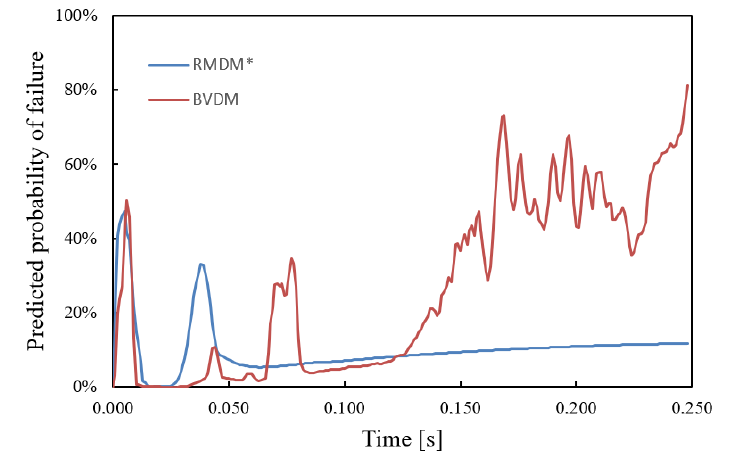
Figure 6. Comparison of the predictions of RMDM ∗ eq and the BVDM, at the beginning of the traumatic event both metrics make similar predictions, but towards the end, when the head rebounds and the axial forces stabilize, the predictions differ